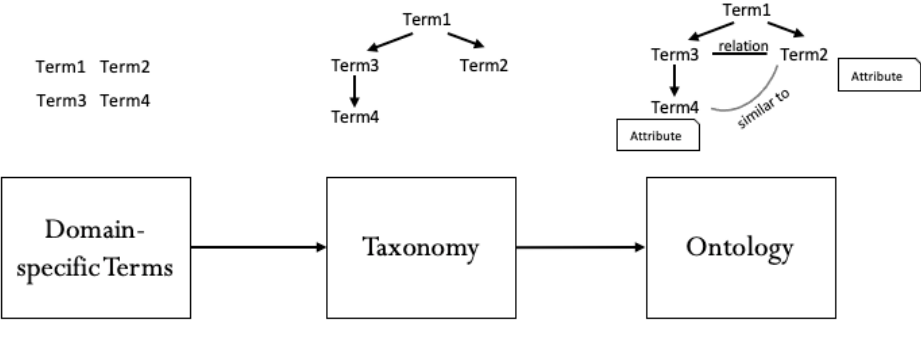
Figure 2. Process of ontologizing a